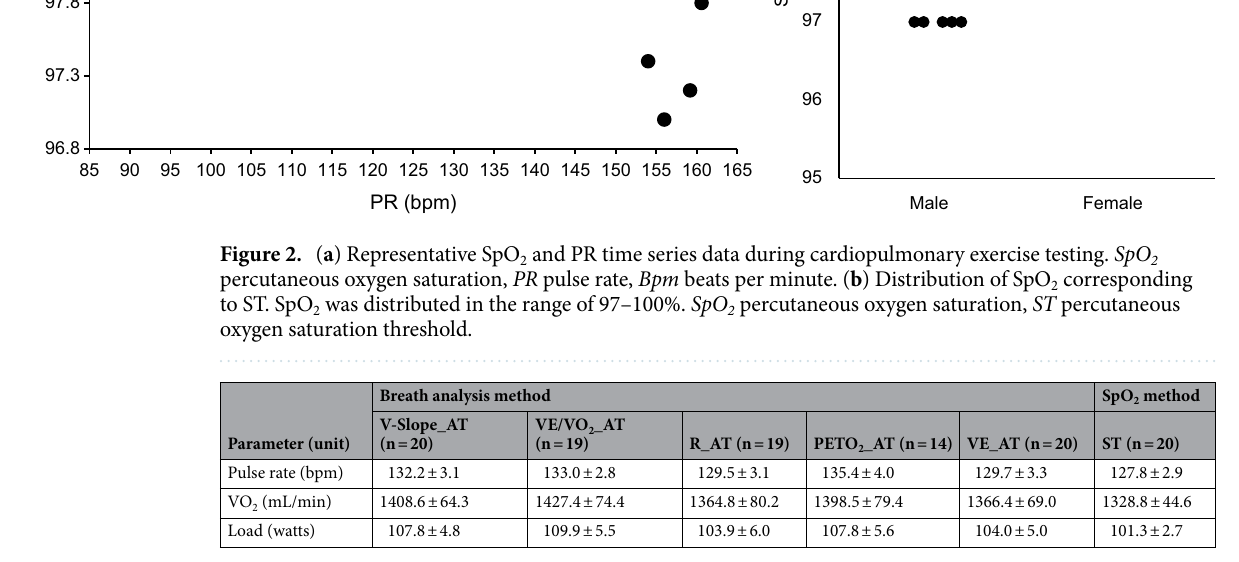
Table 2. Pulse rate, VO 2, and Lad of each AT and ST. Values are presented as mean ± SE. Bpm beats per minute, VO 2 oxygen consumption, SpO 2 percutaneous oxygen saturation, V-Slope V-Slope, VE/VO 2 oxygen ventilatory equivalent, R gas exchange ratio, PETO 2 end-tidal oxygen concentration, VE ventilation, AT anaerobic threshold, ST percutaneous oxygen saturation threshold, SE standard